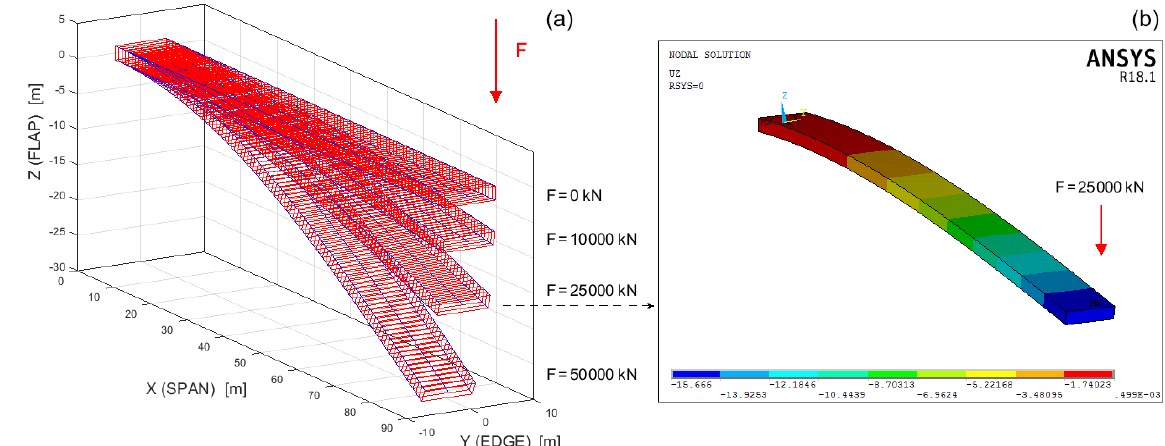
Figure 3. Global deformation with 3D BLM for increasing F (a) and with 3D FEM for F = 25000kN (b)